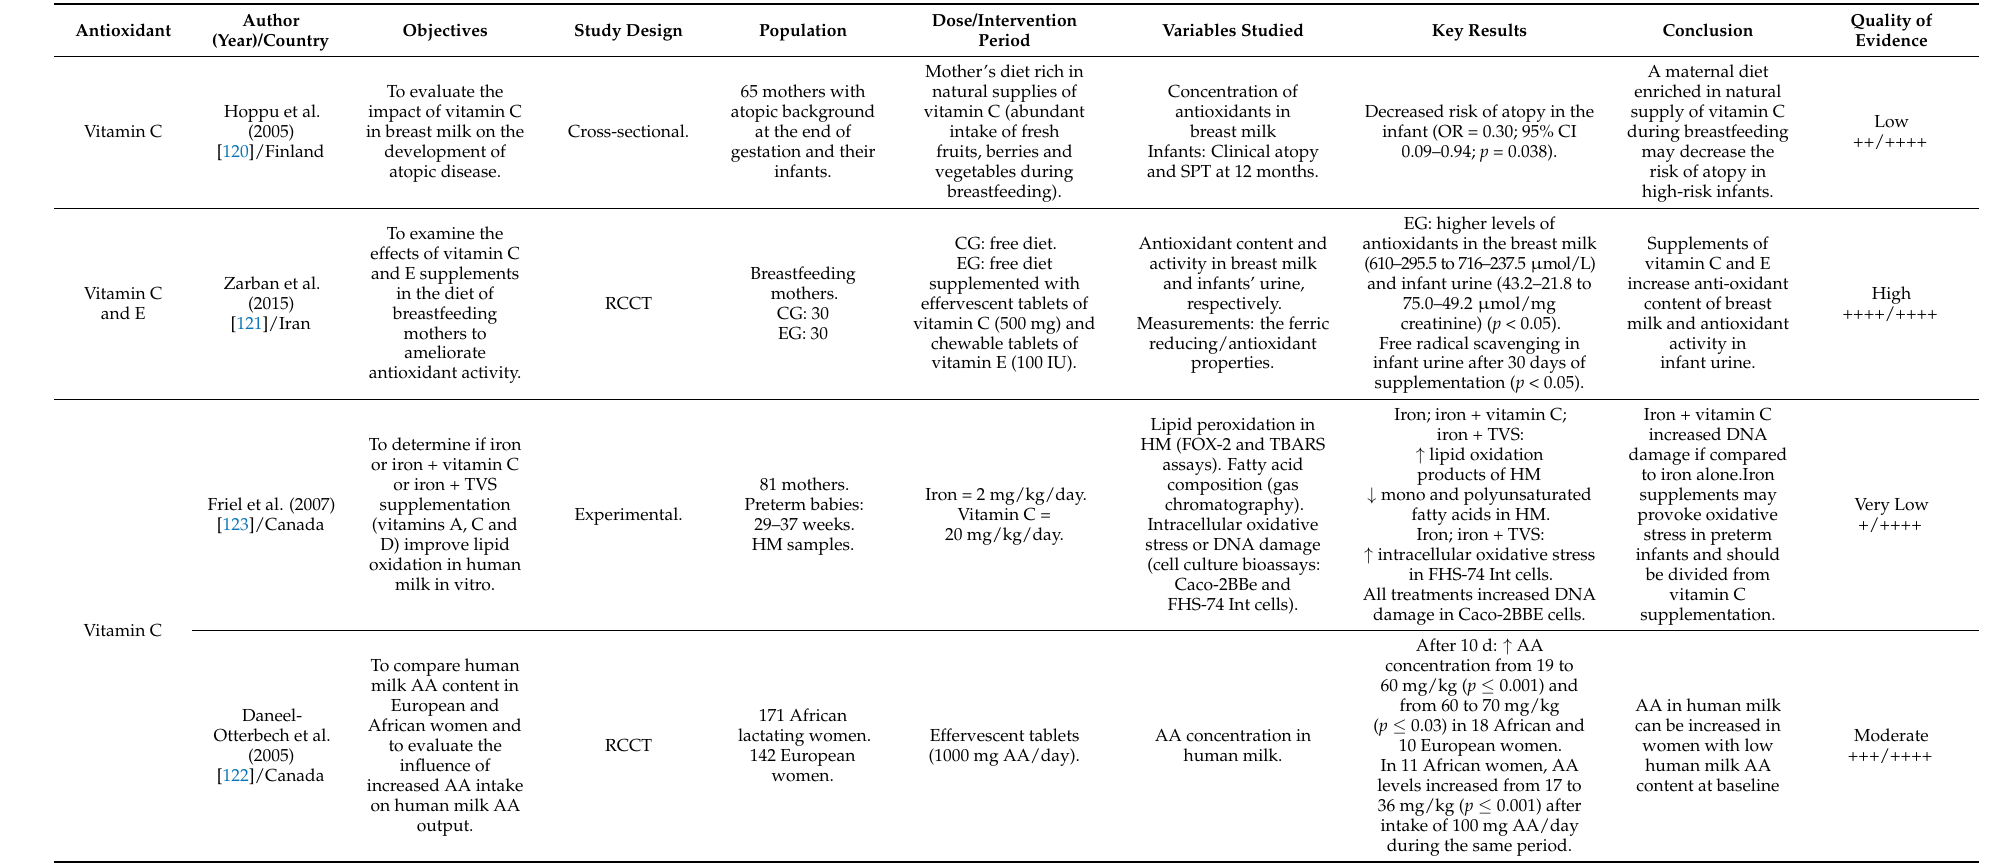
Table 3. Clinical trials about antioxidants supplements in lactating